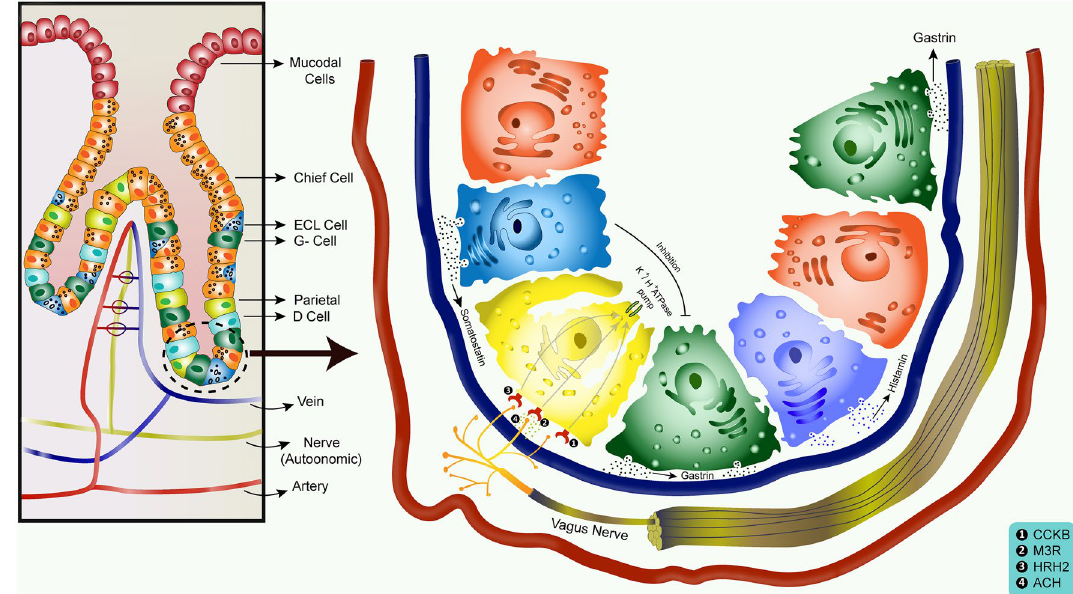
Figure 8. Gastric acid secretion signaling pathway. Gastrin is mainly produced by G- cells that induce CCKβR function. It can result in gastric cancer progression and prompts acid formation in parietal cells. Acetylcholine (ACH) released from the vagus nerve ending binds to Muscarinic M 3 receptors (M3R). Histamine produced by ECL cells binds to HRH2. All these together result in the activation of atp4a gene, which codes K + /H + ATPase pumps and increases acid secretion. D-cells release somatostatin, which has an inhibitory effect on G-cells finally resulting in reducing the acid secretion. *HRH2: histamine receptor H2; ECL: enterochromafin